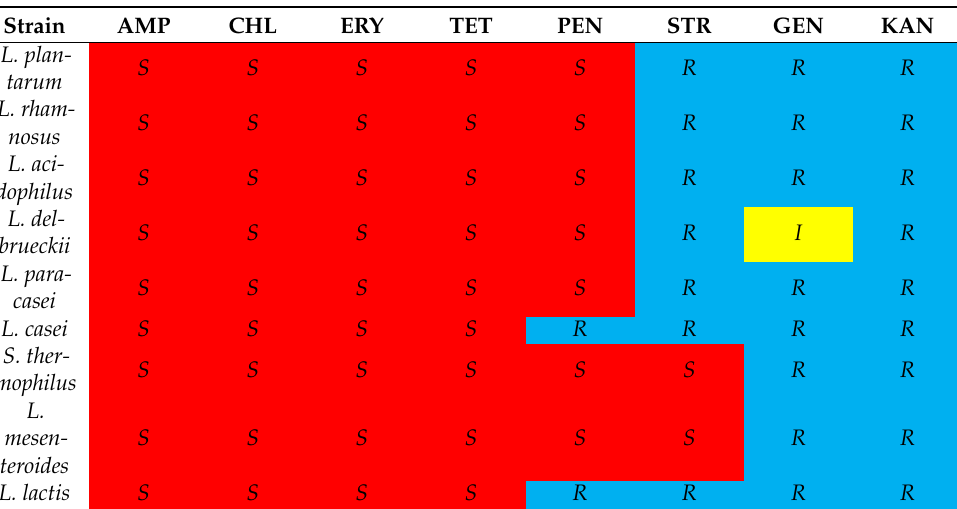
Table 3. Antibiotic